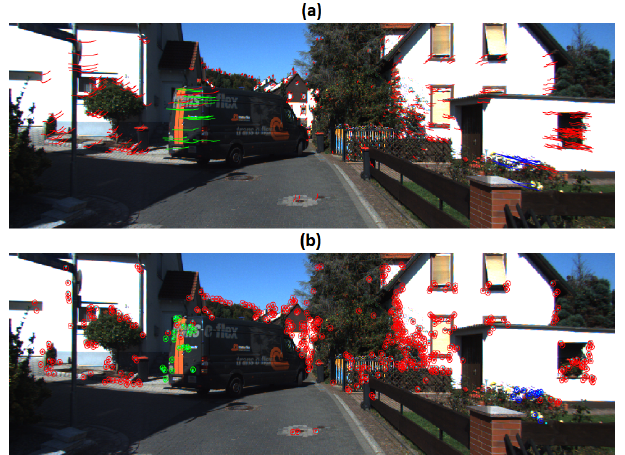
Figure 4. Results of Scene 2: ( a ) Trajectories of the vehicle; ( b ) Reprojection error.